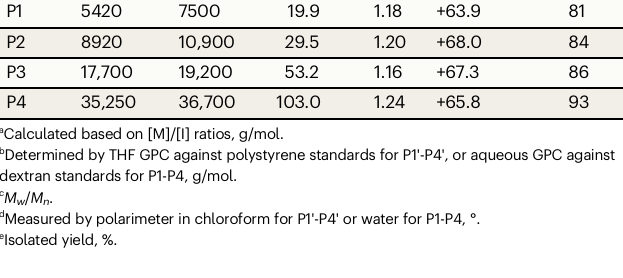
aromatic C-H stretch at 3000 – 3100cm − 1 in the FTIR spectra (Supple-